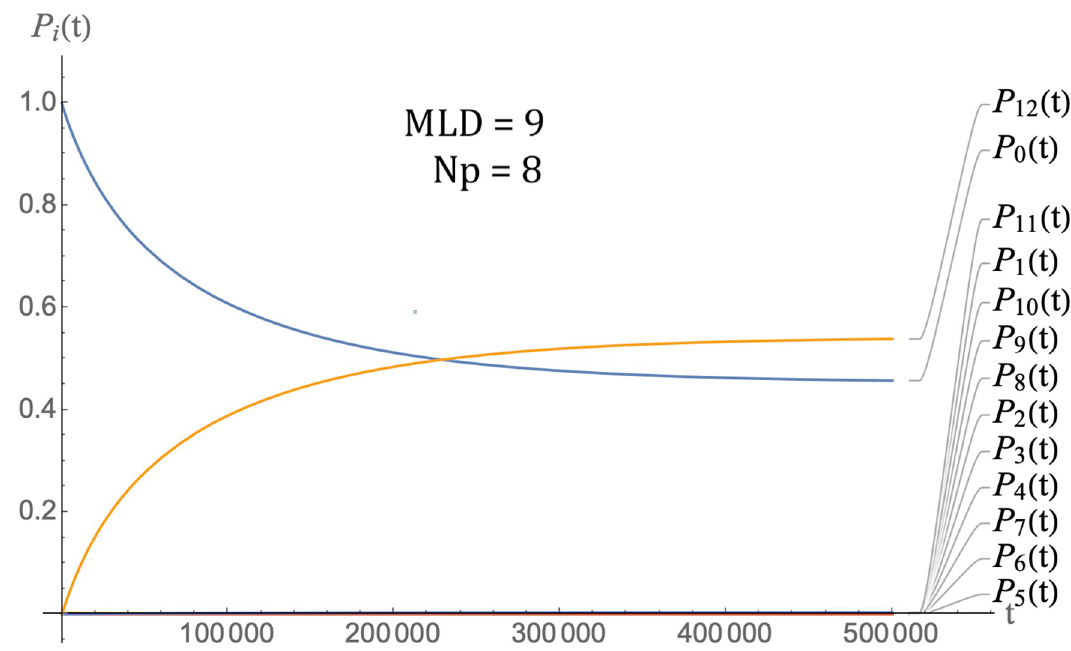
Fig 7. Packaging kinetics of MLD = 9 and N 1, D = 0.5 and μ 0 = − 4. Bottom: Packaging kinetics of MLD = 19, N p = 2 spanning trees with the same parameters.